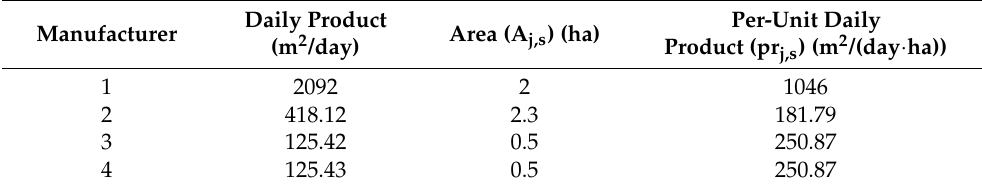
Table 4. Data for Iranian stonecutting factories.